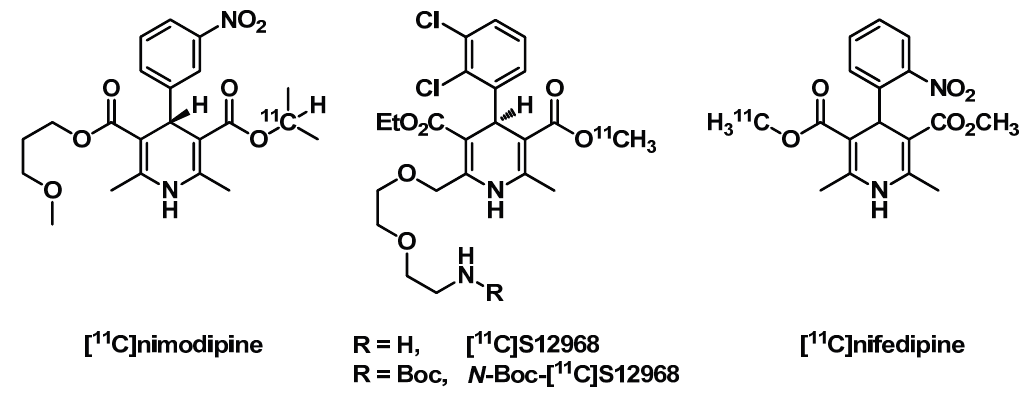
Figure 2. Selected DHP-based PET radiotracers.